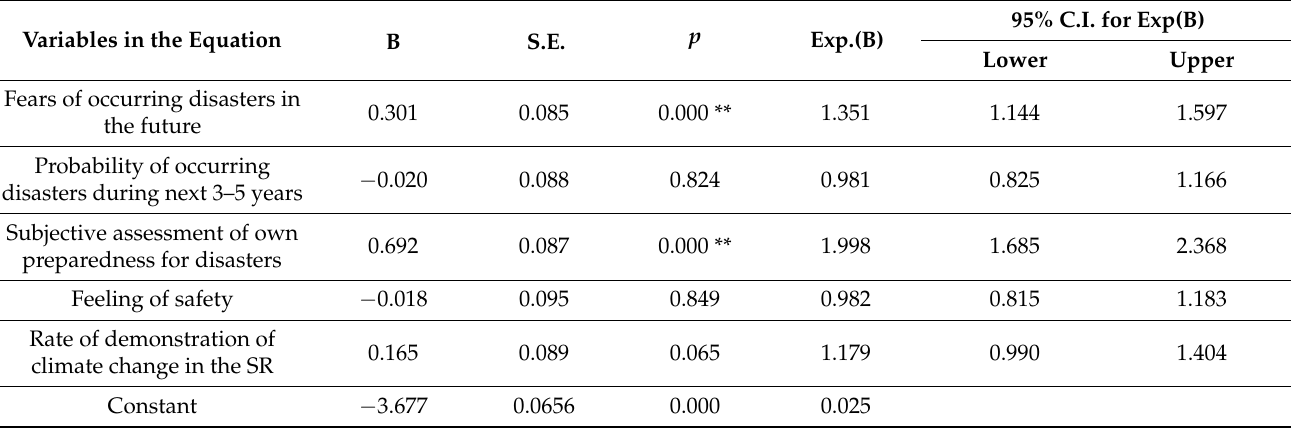
Table 11. Multiple logistic regression analysis investigating factors (disaster perception variables) relating to respondent’s preventive behaviour and disaster